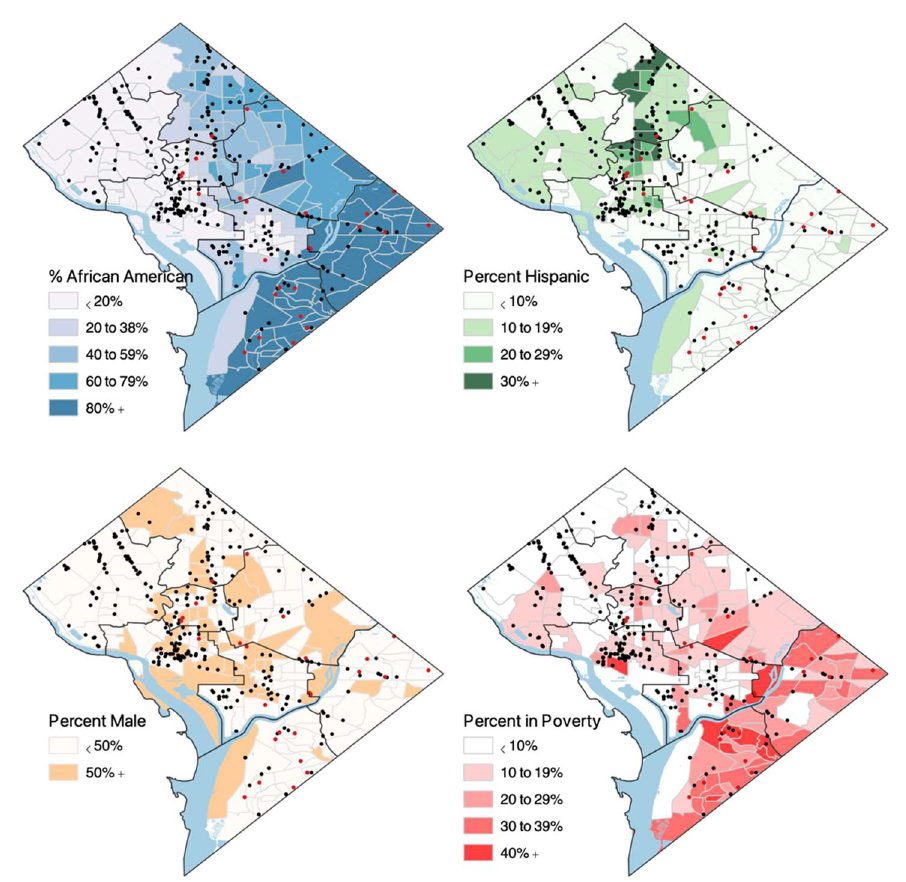
Figure 2. Map of Dental Services & Selected Tract-Level Characteristics.